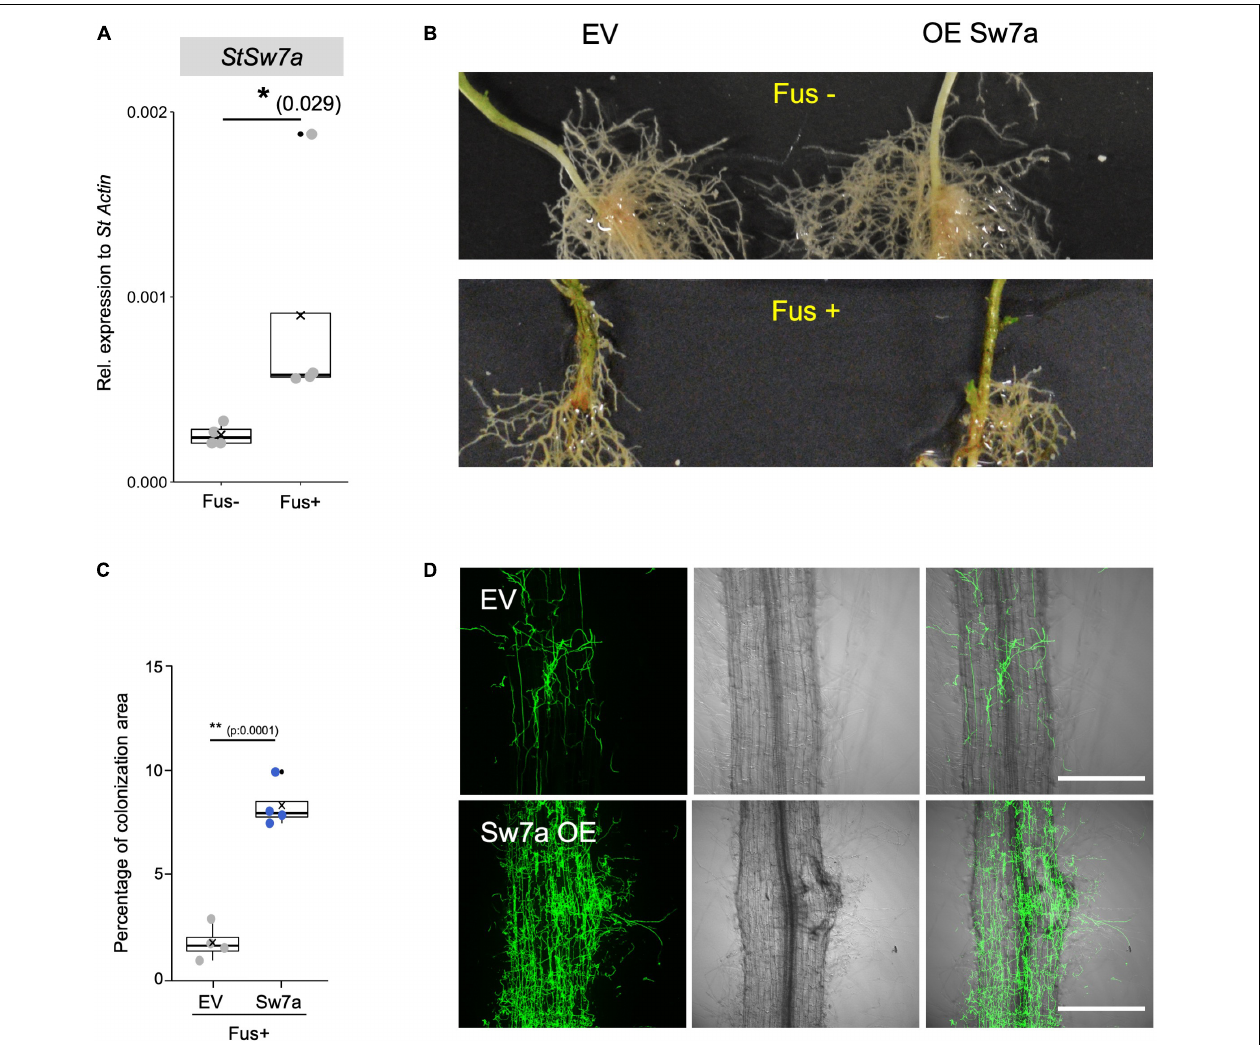
FIGURE 8 | Ectopic expression of StSWEET7a accelerates potato root colonization by Fusarium oxysporum f. sp. tuberosi . (A) Colonization of potato roots by F. oxysporum f. sp. tuberosi significantly induces expression of StSWEET7a as shown by qRT-PCR normalized to StActin . Four biological replicates were analyzed ( n = 4). Significance was calculated with a Mann–Whitney U test and represented by an asterisk, * p < 0.05. (B) Symptoms caused by F. oxysporum f. sp. tuberosi (Fus+) at the base of the shoot in both EV and StSWEET7a composite plants are shown as compared to non-infected plants (Fus–). (C) The extent of colonization by Fusarium was calculated as the fraction of root surface area covered by fungus using the Fiji software after staining the fungus with WGA-FITC. Confocal microscopy pictures from different root regions for each treatment (four biological replicates each) were taken, with n > 17, ( n , number of root sections analyzed for each treatment). (D) Representative confocal microscopy pictures showing the colonization of EV and StSWEET7a overexpressing roots by F. oxysporum f. sp. tuberosi . The fungus was stained using WGA-FITC (left, green channel; center, bright field; right, overlay). Scale bar corresponds to 200 µ